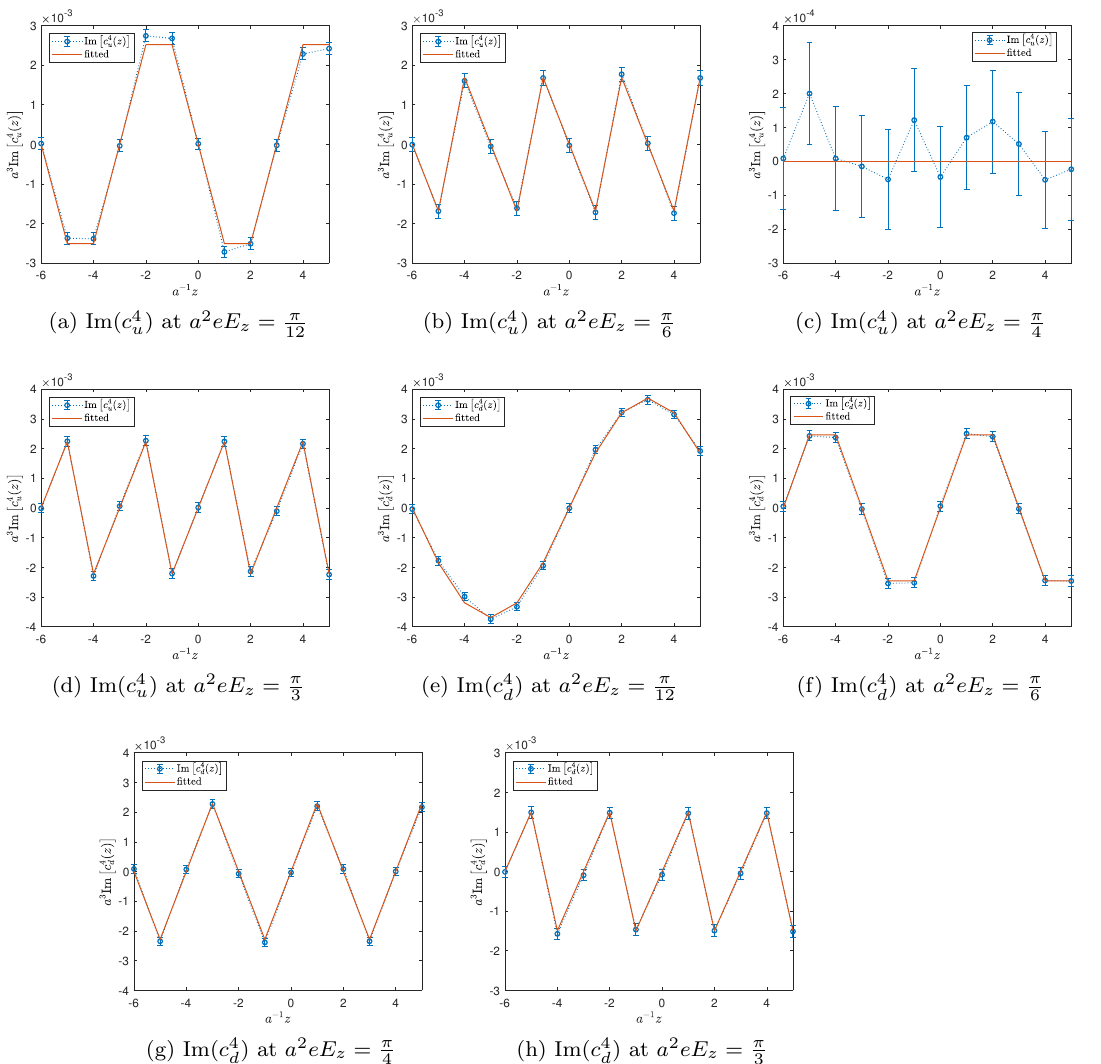
(cid:2) ( z ) (cid:3) at β = 5 . 64 c 4 q